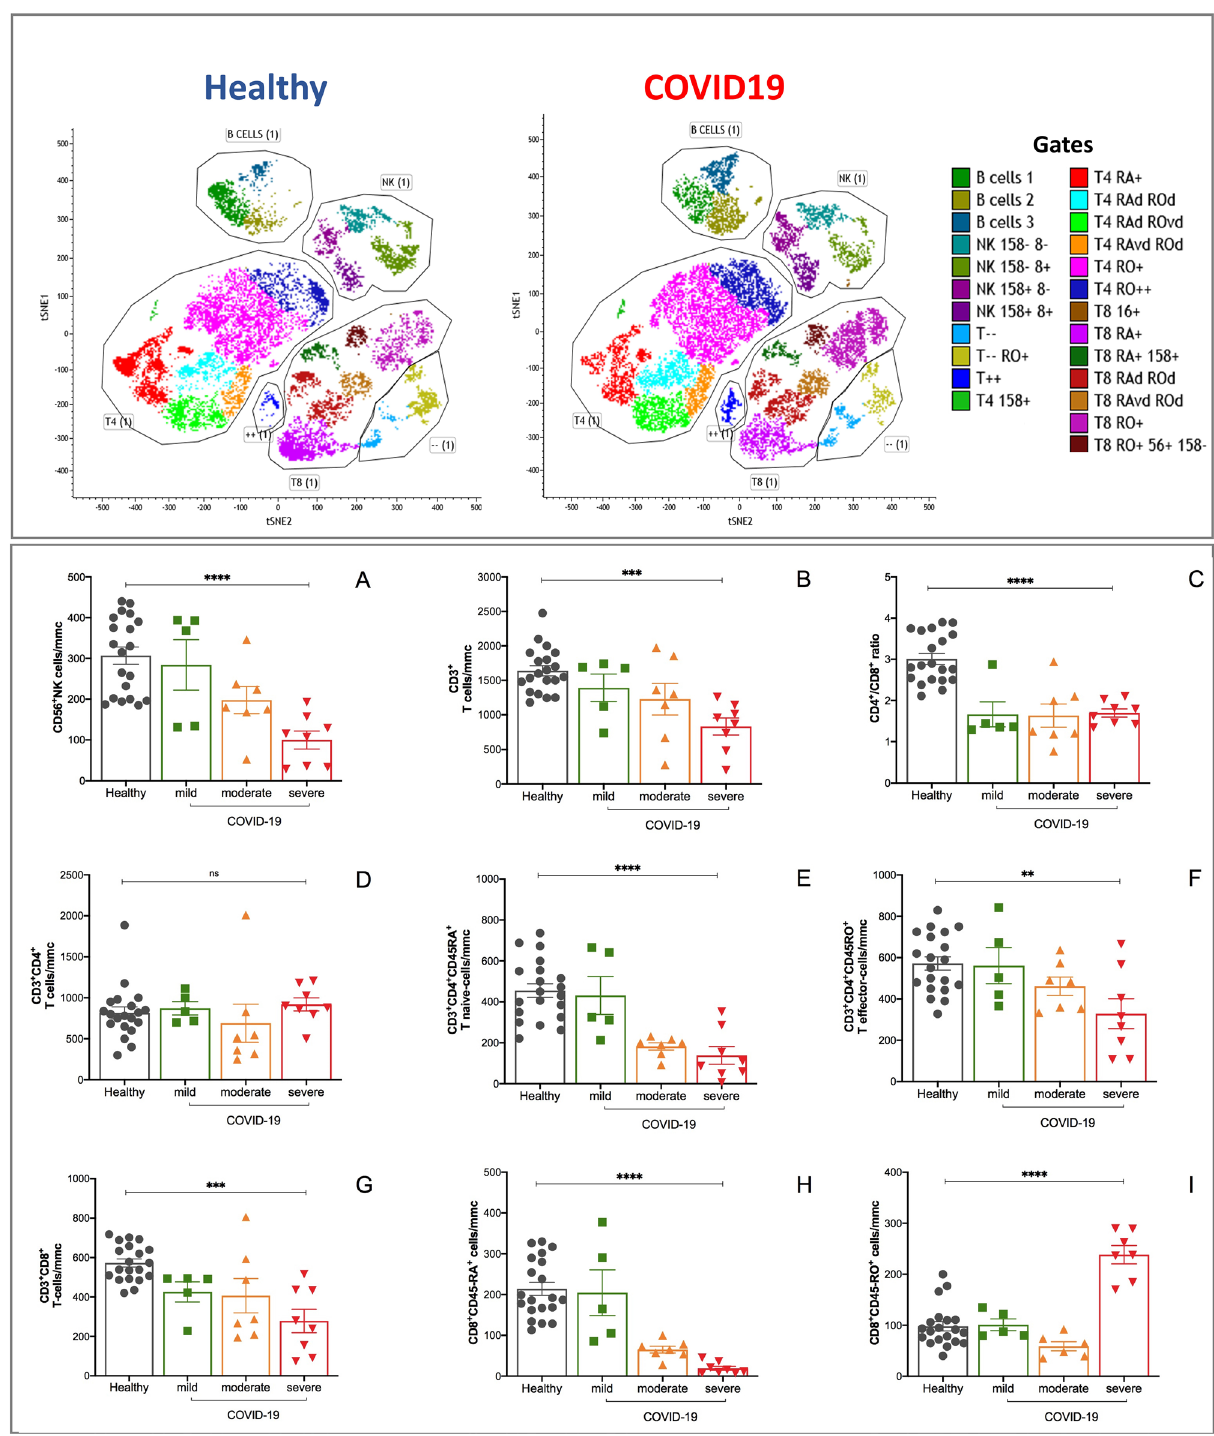
Figure 3. Dysregulation of T-cells composition in peripheral blood of COVID-19 patients. Application of T-distributed stochastic neighbor embedding (t-SNE): clusters were named based on the cluster-specific antigen expression patterns in healthy subjects (A) and COVID-19 patients (B) . Ratio between absolute counts of CD4 + /CD8 + T-cells (C) , CD4 + CD45RA + /CD8 + CD45RA + /T-cells (D) and CD4 + CD45RO + /CD8 + CD45RO + /T- cells (E) , CD4 + T-cells (F) , CD4 + CD45RA + (G) , CD4 + CD45RO + (H) , CD8 + T-cells (I) , CD8 + CD45RA + (L) , CD8 + CD45RO + (M) are shown. Color code: grey, healthy subjects; green, mild COVID-19; orange, moderate COVID-10, red, severe COVID-19. COVID-19 severity was defined according to qCSI, based on respiratory rate, pulse oximetry and oxygen flow rate. Stars denote significance according to ANOVA test among the three COVID groups (mild, moderate, severe), *p < 0.005, **p <